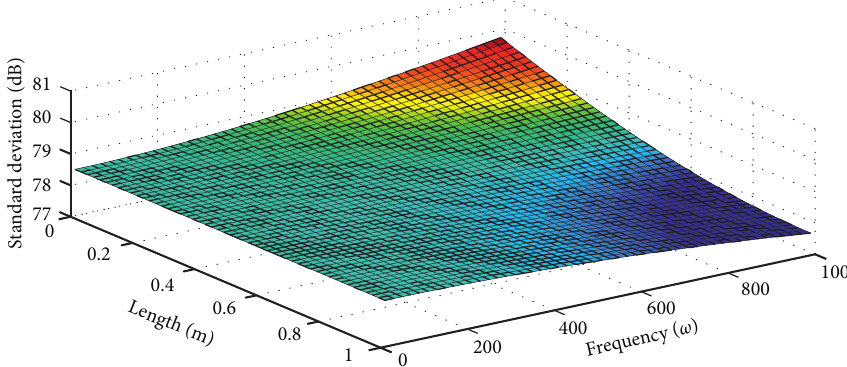
Figure 7: Standard deviations of energy densities of the rod. The reference energy density is 10 − 12 J/m 2 .